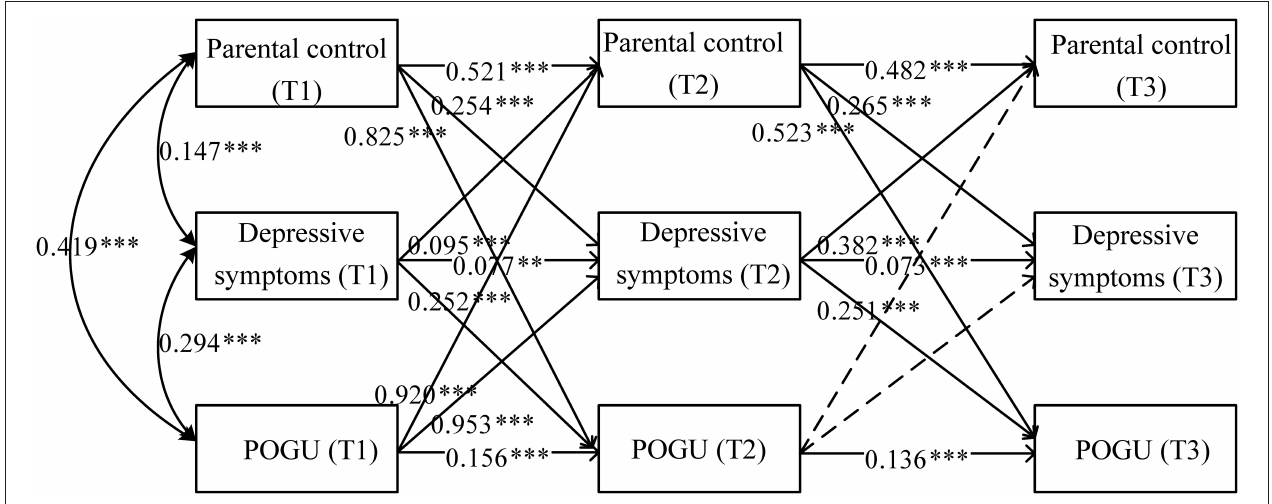
FIGURE 2 | Developmental cascades model of parental control, depressive symptoms, and POGU at T1, T2, and T3. POGU, problematic online game use. Dashed lines represent non-significant paths. The path coefficients are standardized coefficients. ** p < 0.01, *** p < 0.001.